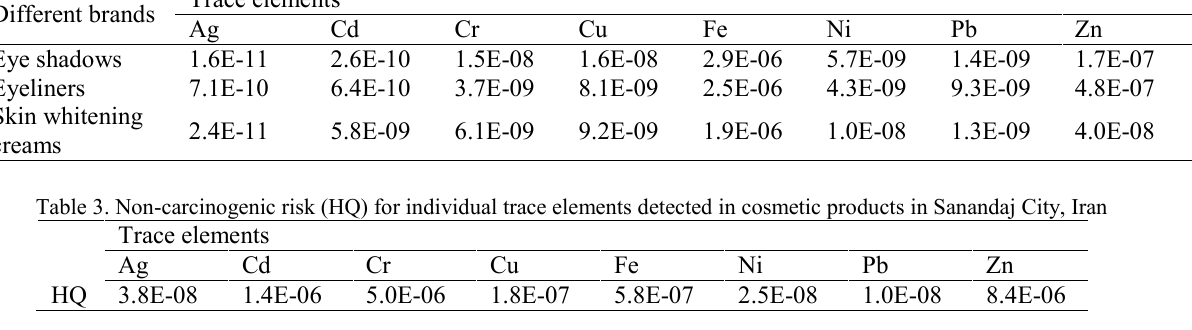
Table 2. Chronic daily intake (CDI) for individual trace elements detected in cosmetic products in Sanandaj city, Iran Different brands Eye shadows